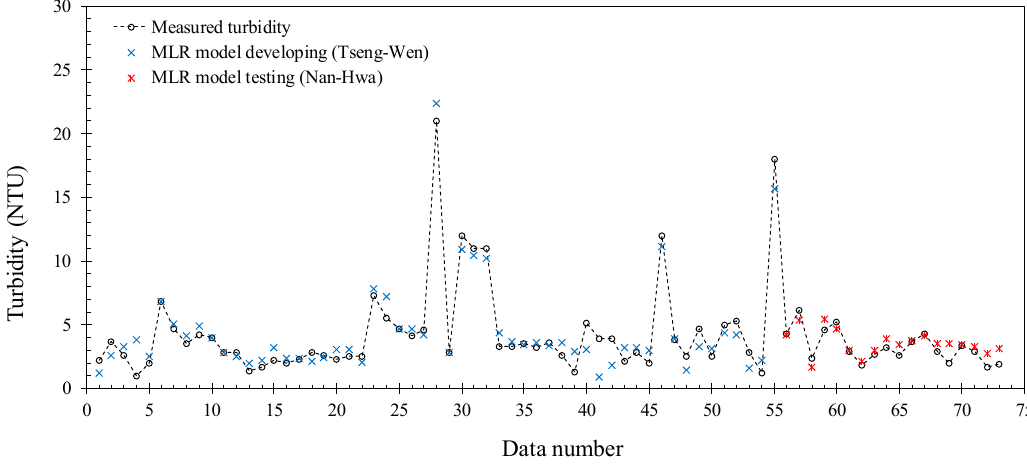
Figure 6. The relationship of observed turbidity and multiple linear regression (MLR) simulated turbidity in Tseng-Wen and Nan-Hwa reservoir.